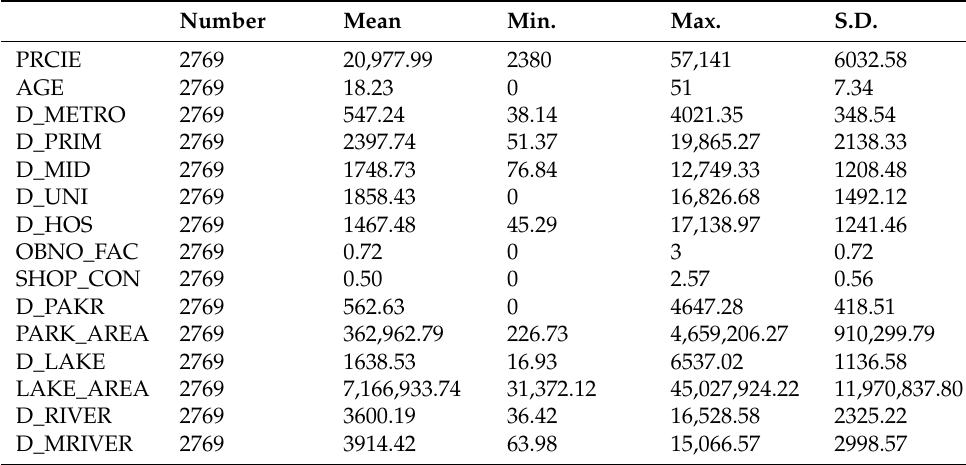
Table A7. Descriptive statistics of data in Wuhan.